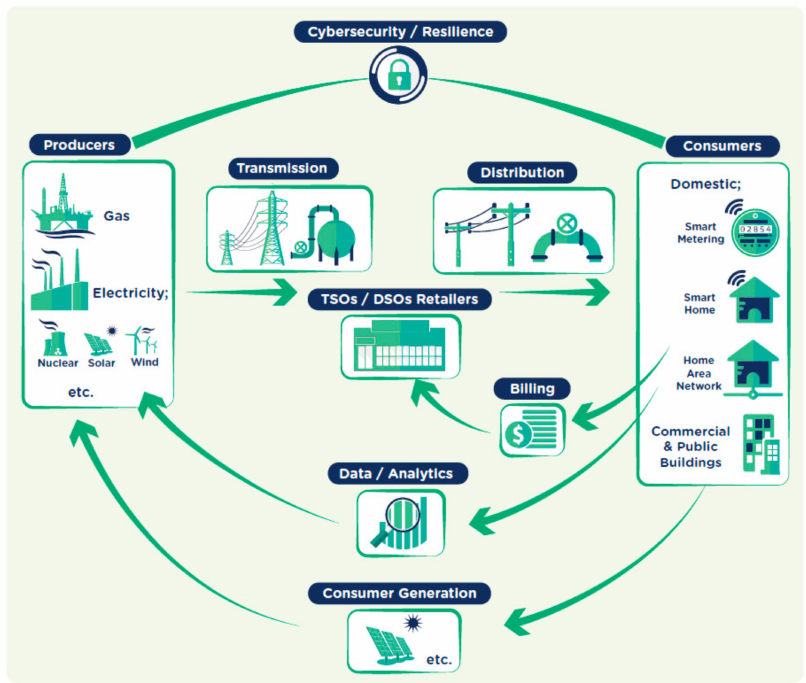
Figure 1. Infographic a modern energy supply chain (source: Beecham Research